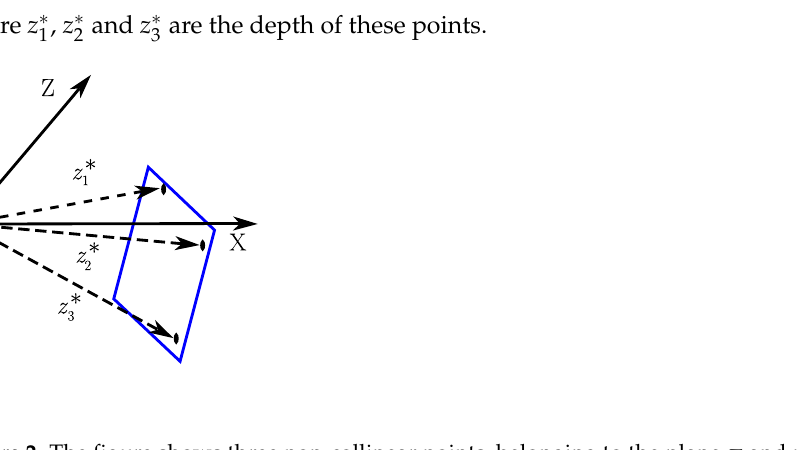
Figure 2. The figure shows three non-collinear points, belonging to the plane π and projected onto the reference image I ∗ with depths z ∗